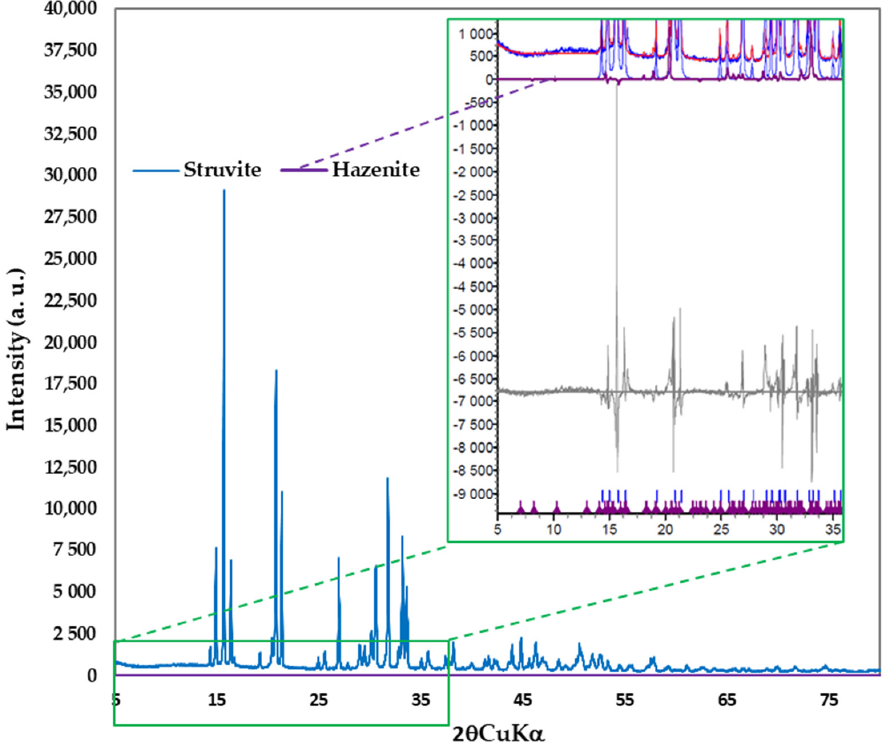
Water 2021 , 13 , x FOR PEER REVIEW Figure 2. XRD pattern of precipitate Sample 1—molar ratio PO 43- :Mg 2+ 1:1. Figure 2. XRD pattern of precipitate Sample 1—molar ratio PO 43- :Mg 2+ 1:1.